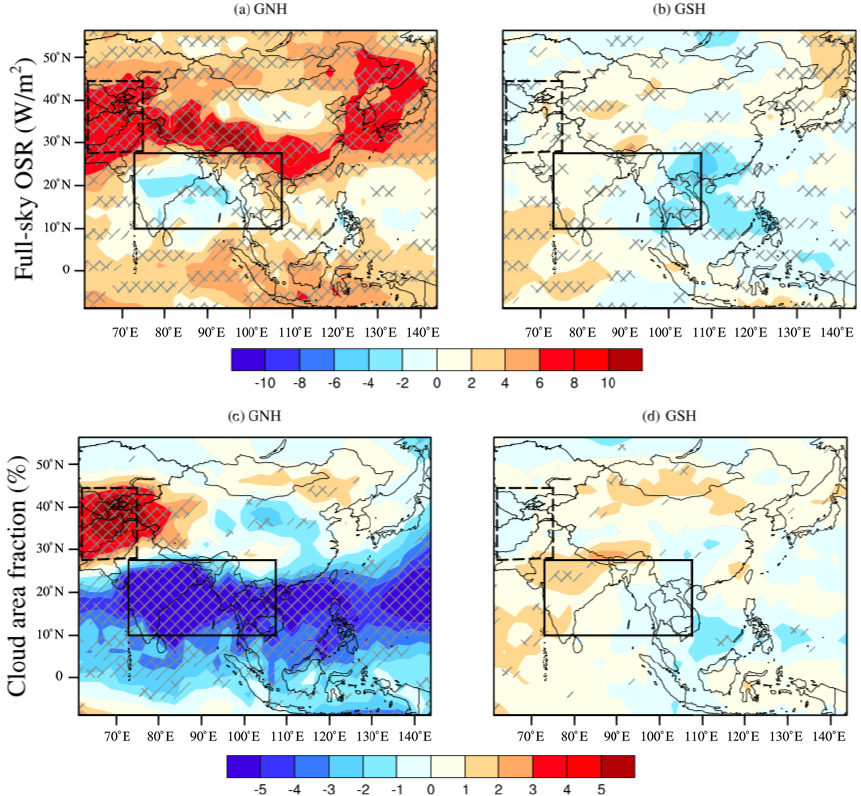
Figure 10. Spatial distribution of top-of-the-atmosphere outgoing shortwave radiation (TOA OSR; Wm − 2 ; a , b ) in full-sky and cloud area fraction (%; c , d ) anomalies in the eruption year with respect to the mean of 5 years before the eruption. The solid and dashed black boxes indicate the relatively wettest area (RWA) and relatively driest area (RDA), respectively. The gray slashes and cross signs indicate the significant results at the 95% and 99% confidence